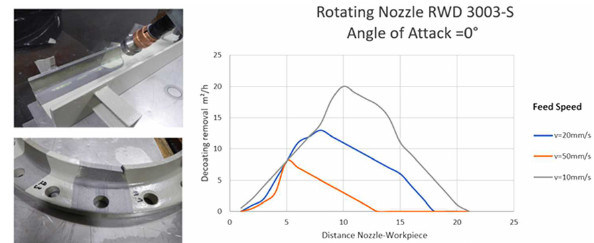
Fig. 4. Experiments on complex objects. It is easy to see that the angle of incidence is a critical parameter. The diagram on the right shows the removal rate on the Y axis and the distance on X at a given speed. One recognizes that a further approach to the workpiece surface of the nozzle does not necessarily pro- duce a better cleaning performance – there are maxima.